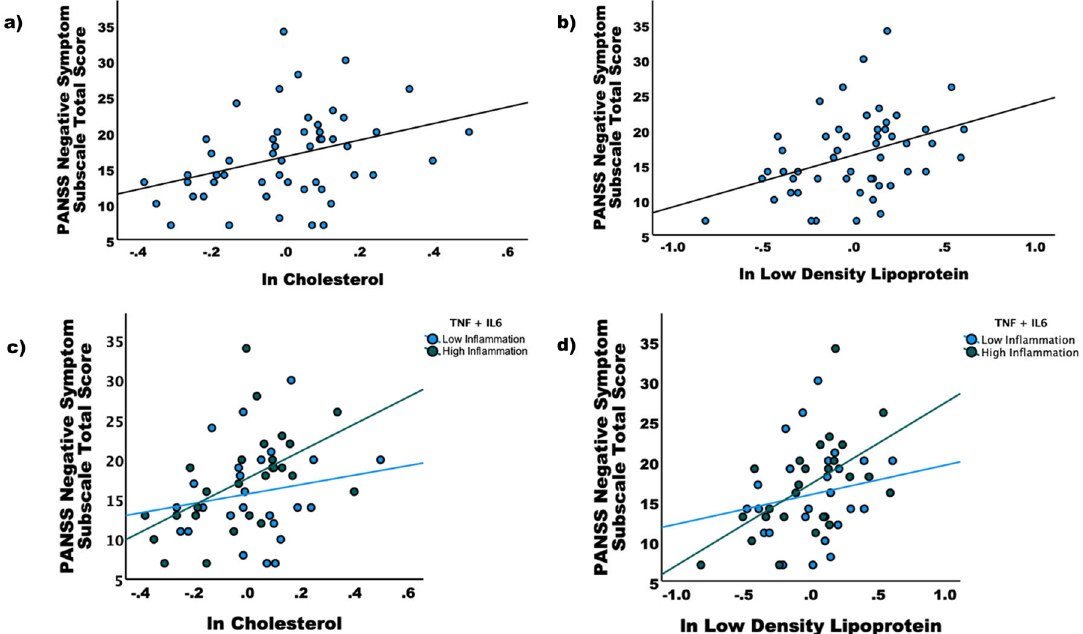
Fig. 1 Correlations between Positive and Negative Syndrome Scale (PANSS) Negative Symptom Subscale Score and total cholesterol and low-density lipoprotein (LDL). Of the metabolic markers, only ( a ) total cholesterol ( r = 0.387, p = 0.005) and ( b ) LDL ( r = 0.356, p = 0.009) were signi fi cantly correlated with the PANSS negative subscale score. The sample was split between those with high and low in fl ammation as indexed by a median split of a composite score of tumor necrosis factor (TNF) and interleukin-6 (IL-6). In the low in fl ammation subgroup ( c ), there was no relationship between PANSS Negative Symptom Subscale Score and cholesterol ( p = 0.514) or LDL ( p = 0.317), whereas in the high in fl ammation subgroup ( d ) signi fi cant correlations were found for total cholesterol ( p = 0.001) and LDL ( p =